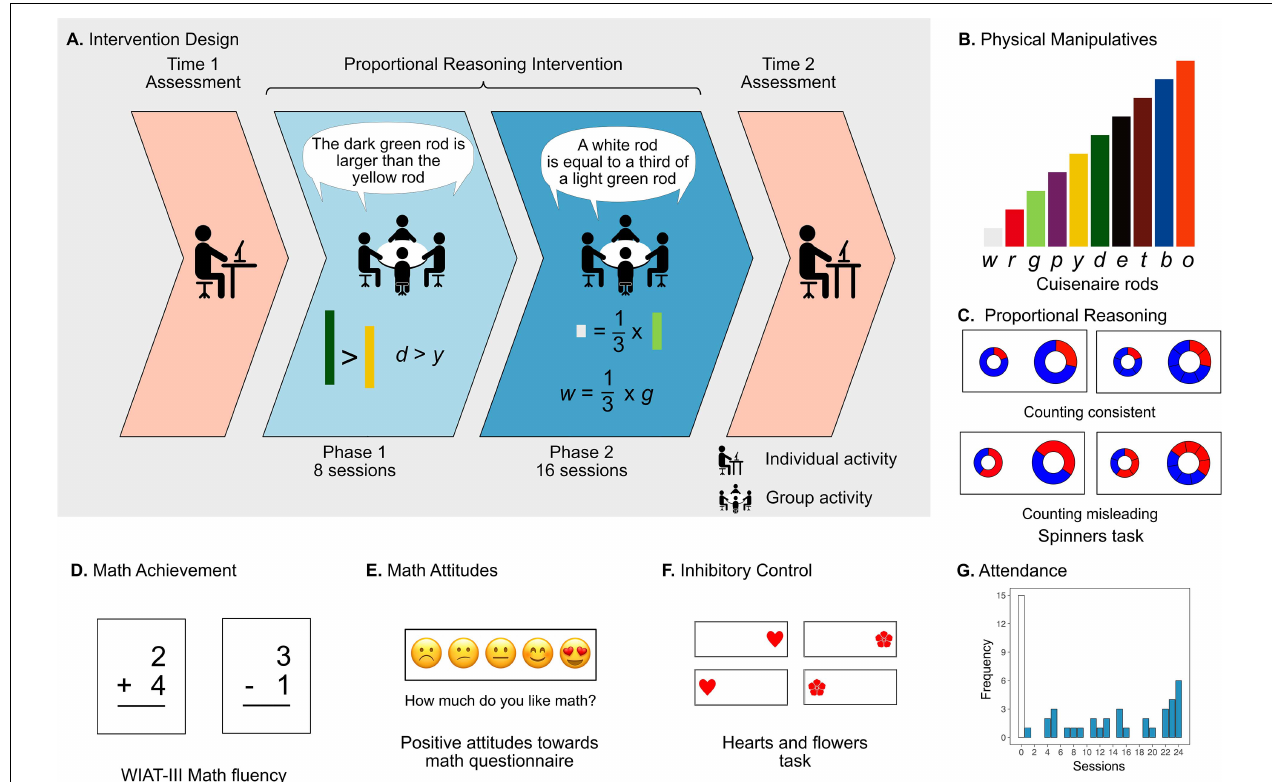
FIGURE 1 | Study design. (A) The study consisted of three stages: the time 1 assessment (late September 2018), 24 sessions of a group-based proportional reasoning intervention, and (3) a time 2 assessment (March 2019), which repeated the time 1 assessment. The intervention was further divided into two phases: Phase 1 (8 sessions), in which children became familiarized with the materials and manipulated absolute magnitudes, physically, orally and symbolically; Phase 2 (16 sessions), in which children represented and compared non-symbolic and symbolic proportions. (B) During both phases, children initially worked with the physical rods and then they used letters to refer to the rods (w = white, r = red, g = green, p = purple, y = yellow, d = dark green, e = ebony, t = tan, b = blue, o = orange). The time 1 and time 2 assessment comprised of (C) the spinners task, the main outcome task, which comprised continuous (left pairs spinners) and discrete (right pairs of spinners) formats (D) the arithmetic fluency subtests from the Wechsler Individual Achievement Test (WIAT)-III, (E) the positive attitudes toward math questionnaire, and (F) the hearts and flowers task. (G) The histogram shows the number of children who attended a given number of sessions, from zero sessions (control group) to 24 sessions (complete